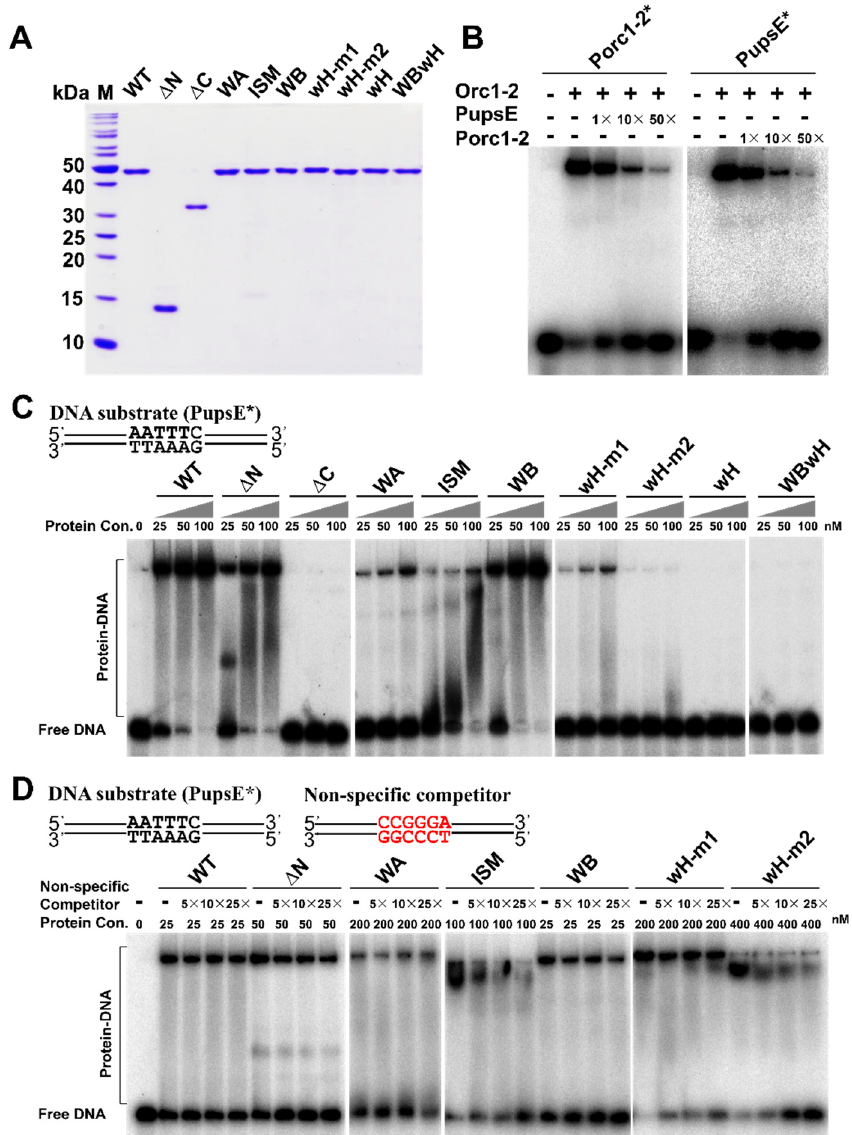
Figure 3. Orc1-2 affinity and specificity for the promoter of the DDR gene. ( A ) SDS-PAGE analysis of the wild-type Orc1-2 protein and its mutant derivatives purified from E. coli . Δ N, N-terminal domain (ATPase) truncation mutant; Δ C, C-terminal domain (wH) truncation mutant; WA, K72A at Walker A motif; ISM, G127DL128D at the initiator-specific motif (ISM); WB, E154A at Walker B motif; wH-m1, R353AR354A at the wH domain; wH-m2, R381AR383A at the wH domain; wH, quadruple substitutions at the wH domain; WBwH, pentuple substitutions at Walker B motif and wH domain. ( B ) EMSA assay of the wild-type Orc1-2 protein using the promoters of orc1-2 and upsE genes. P orc1-2 * and P upsE * DNA probes are of 46 bp promoter fragment containing 6 bp DDRE motif in the center and 20 bp flank region on each side. Binding assay was conducted with 25 nM Orc1-2 and ~2 nM radiolabeled probe (Porc1-2* or PupsE*) in the presence of the indicated amounts of unlabeled specific competitor. ( C ) Effects of mutation of each Orc1-2 domain on its interaction with the upsE promoter. DNA binding assays were performed with the indicated amounts of the WT or one of the mutated Orc1-2 proteins in the presence of ~2 nM radiolabeled PupsE* probe. ( D ) Determinants of the specific interaction between Orc1-2 and the promoter of upsE . DNA binding was conducted with an indicated amount of Orc1-2 or its mutant protein, ~2 nM radiolabeled PupsE*, and a specified amount of unspecific competitor DNA and analyzed by native